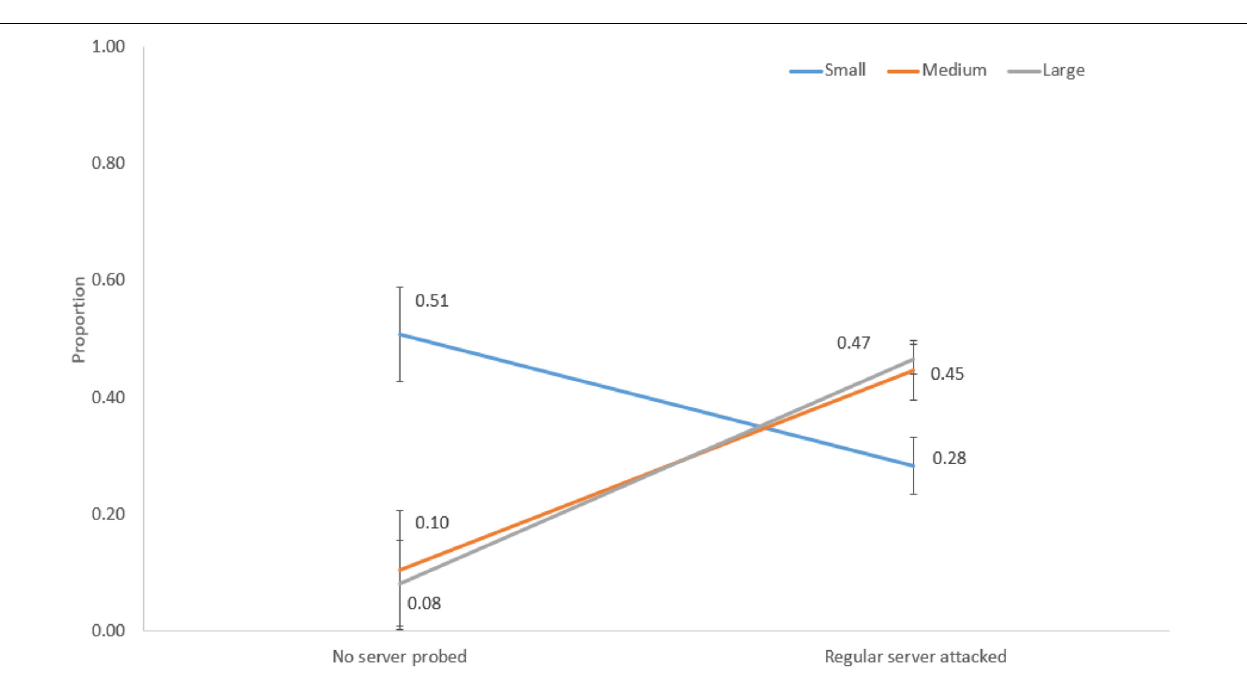
proportions of regular server attacked decisions were 0.45 and 0.47,